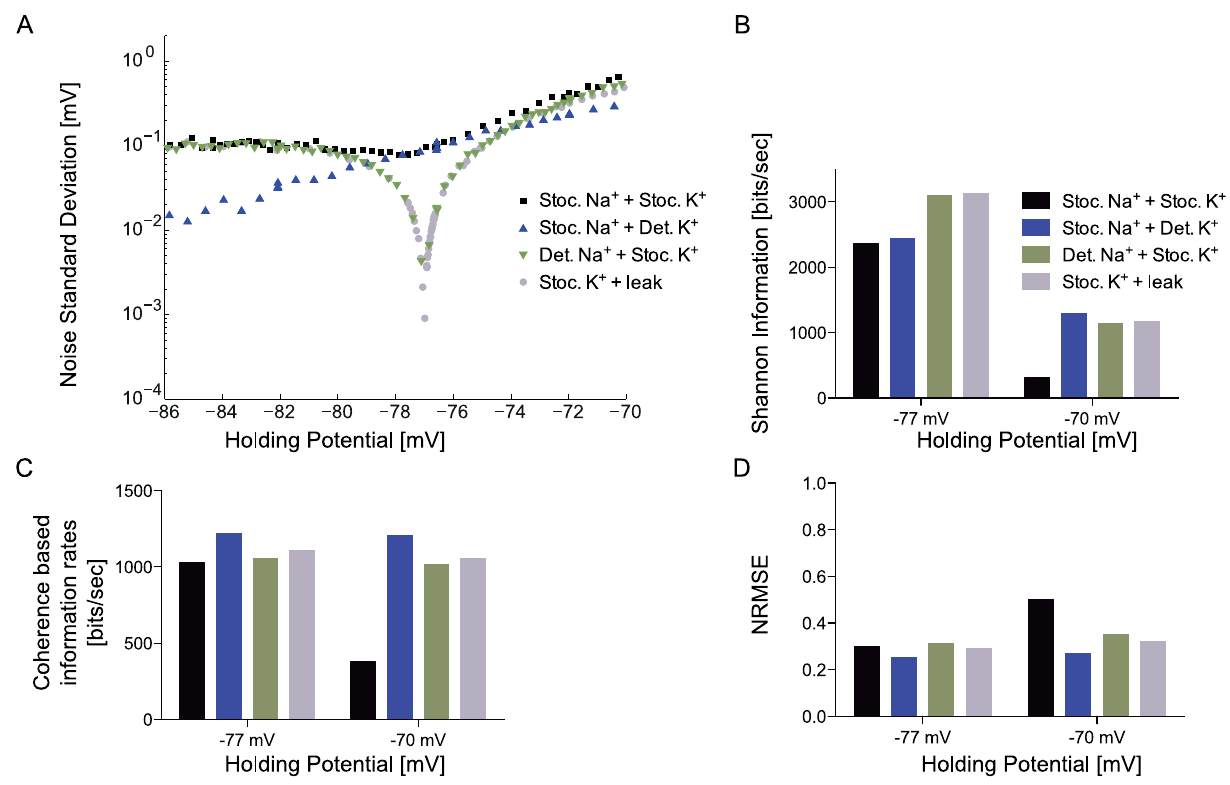
Figure 7. The effects of channel noise upon sub-threshold and graded voltage signals. A. The standard deviation of the voltage of the spiking neuron model (stochastic voltage-gated Na + and K + channels), a modified model with stochastic voltage-gated Na + and deterministic voltage- gated K + channels, a modified model with deterministic voltage-gated Na + and stochastic voltage-gated K + channels, and the graded neuron model (stochastic voltage-gated K + channels) over a 16 mV range of holding potentials. B. Shannon information rates of all four models shown in A evoked by low mean, high standard deviation current stimuli at sub-threshold holding potentials. C. Coherence-based information rates of all four models shown in A evoked by low mean, high standard deviation current stimuli at sub-threshold holding potentials. D. Normalized mean square error (nRMSE) information rates of all four models shown in A evoked by low mean, high standard deviation current stimuli at sub-threshold holding